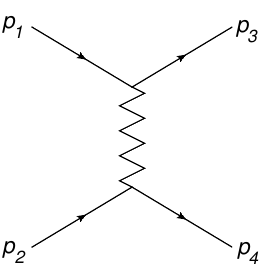
Figure 5: Exchange of a particle of spin J in the t -channel of 2 → 2 scattering, where we consider the physical scattering (from left to right) in the s -channel.